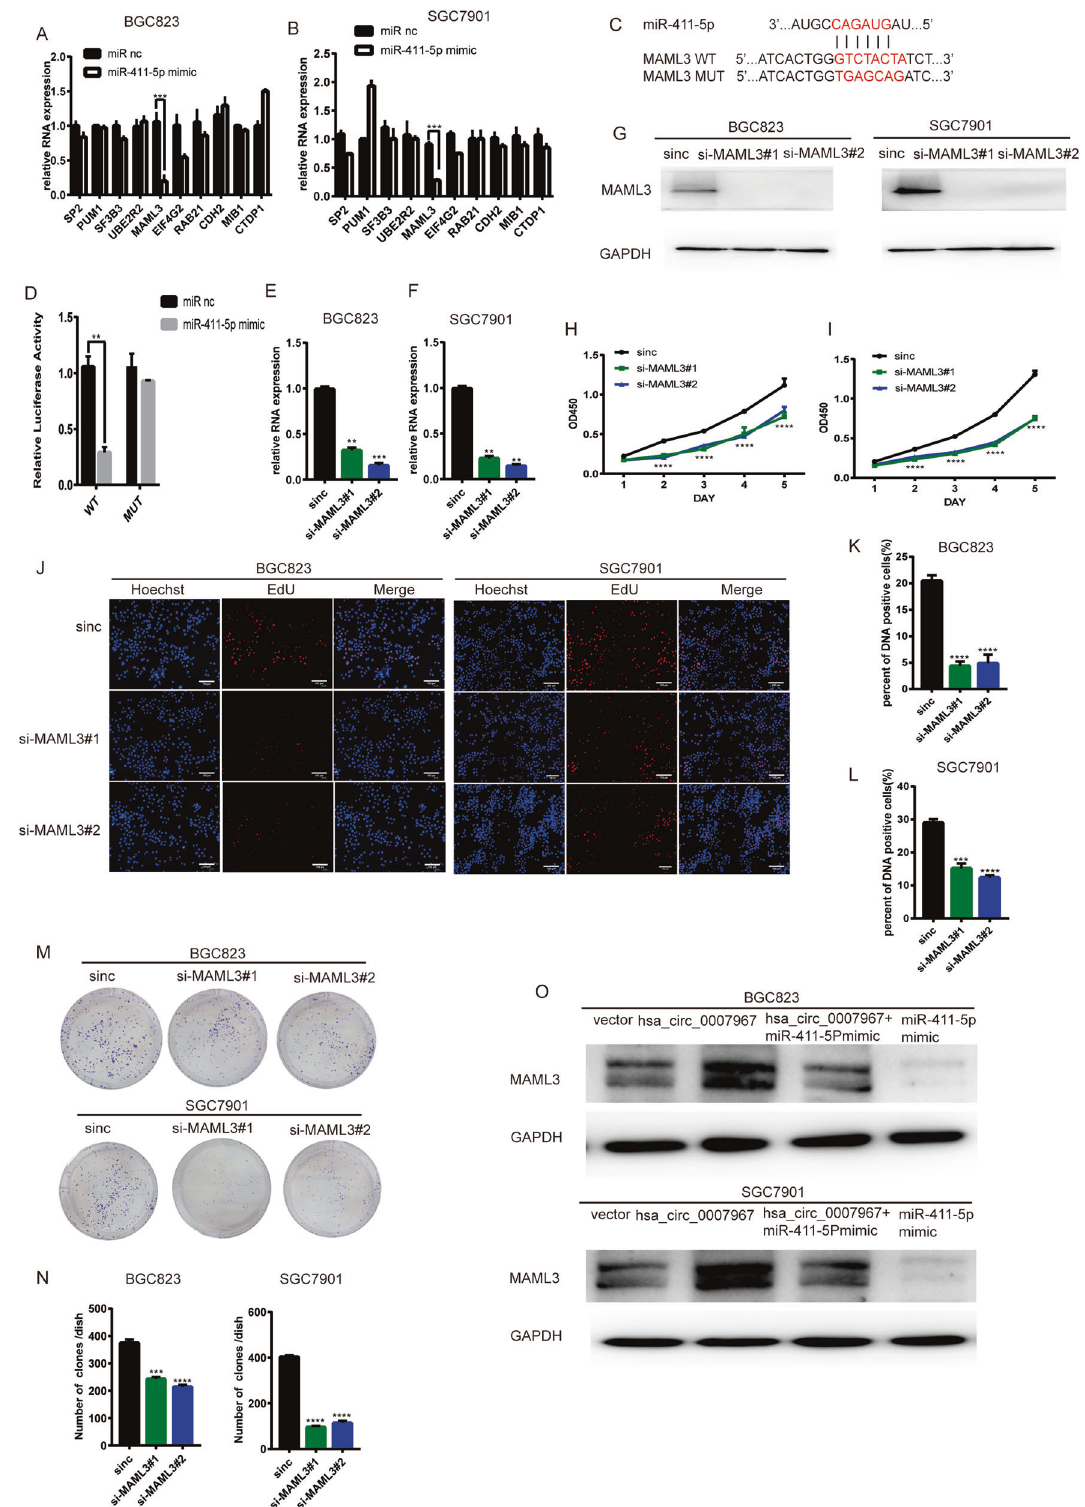
Hsa_circ_0007967 promotes GC cell proliferation in vitro and in vivo To explore whether hsa_circ_0007967 involves in the progression of GC, we fi rst overexpressed hsa_circ_0007967 in BGC823 and SGC7901 cells (Fig. 2A, B). Cck8 assays showed that cells with